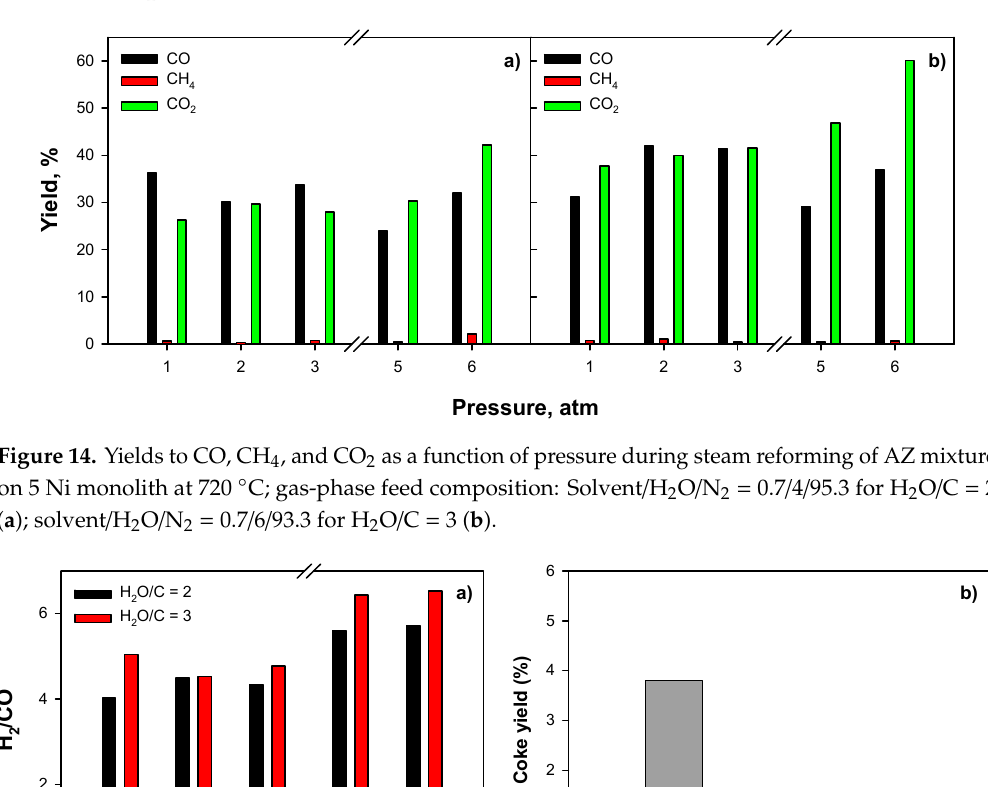
Figure 13. Gas yield as a function of pressure during steam reforming of AZ mixture on 5 Ni monolith at 720 °C; gas-phase feed composition: Solvent/H 2 O/N 2 = 0.7/4/95.3 for H 2 O/C = 2; solvent/H 2 O/N 2 = 0.7/6/93.3 for H 2 O/C = 3.